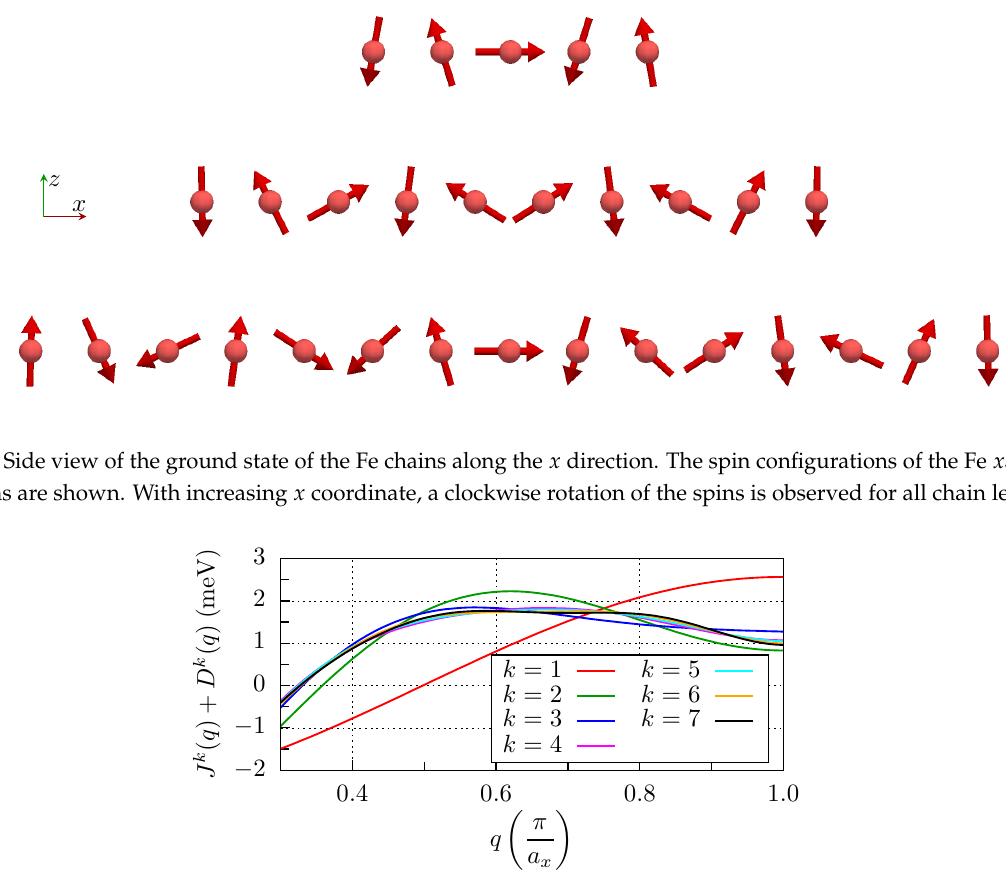
Figure 6. Fourier transform of the magnetic interactions for the Fe x 15 chain. The isotropic and the DM interactions in Equations (10) and (11) are summed